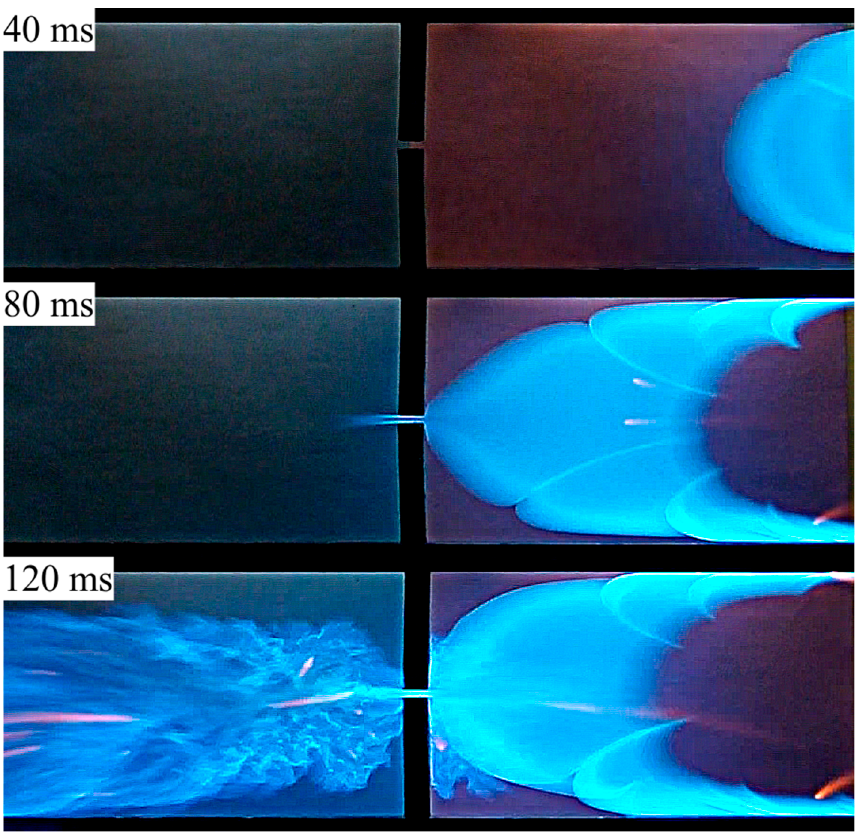
Figure 3. Flame penetration through a hole from the closed ( right ) to open ( left ) channel part: experiment in a channel with distance between plates of 9 mm, 6.5% propane–air mixture.